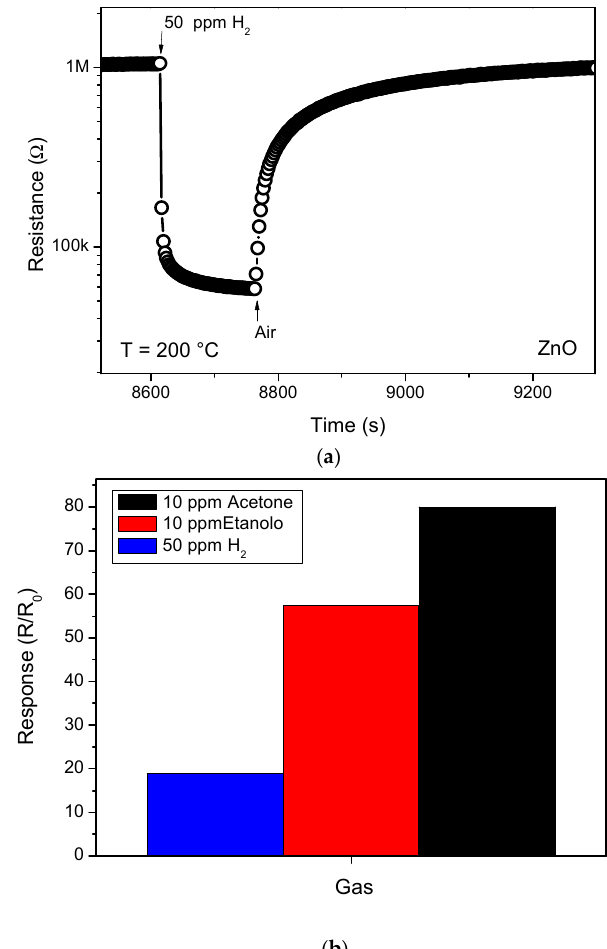
Figure 3. ( a ) Transient response to 50 ppm of H 2 of the ZnO sensor. ( b ) Comparison of the response of the ZnO sensor to H 2 , acetone, and ethanol.